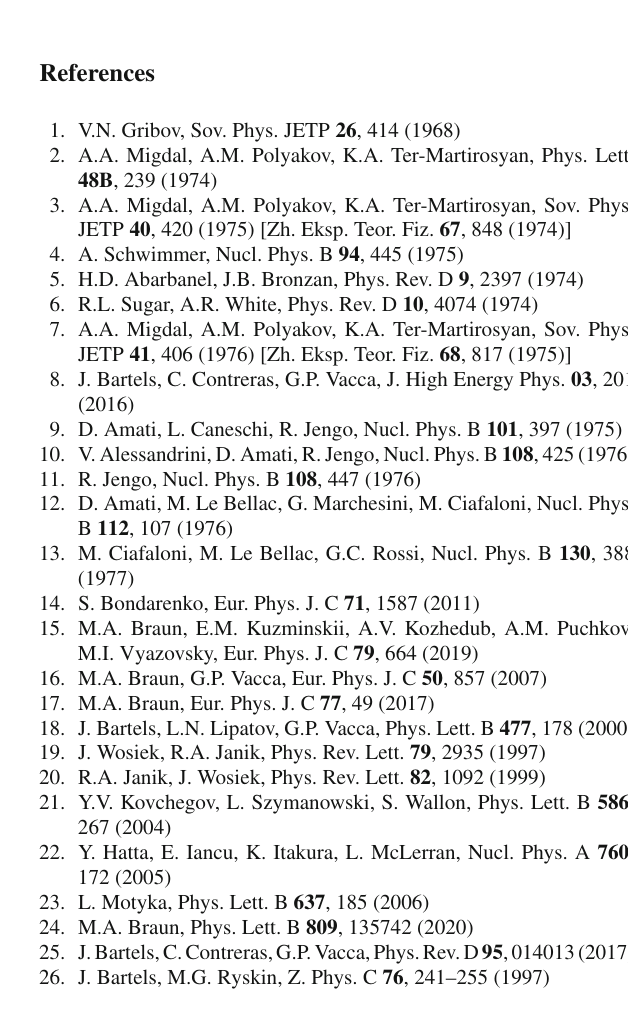
Fig. 11 Pomeron (left panel) and odderon (right panel) propagators at different rapidities for μ = 0 . 1, λ = 0 . 1 with the quadruple interaction. Curves from bottom to top correspond to λ (cid:12) = 0, 0 . 5, 1 . 0 and 2 .